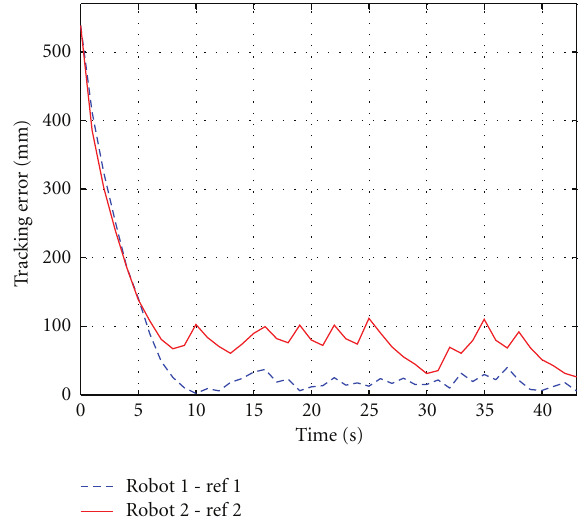
Figure 10: Group movement tracking straight line. Figure 11: Consensus tracking errors for the virtual position: straight line case.